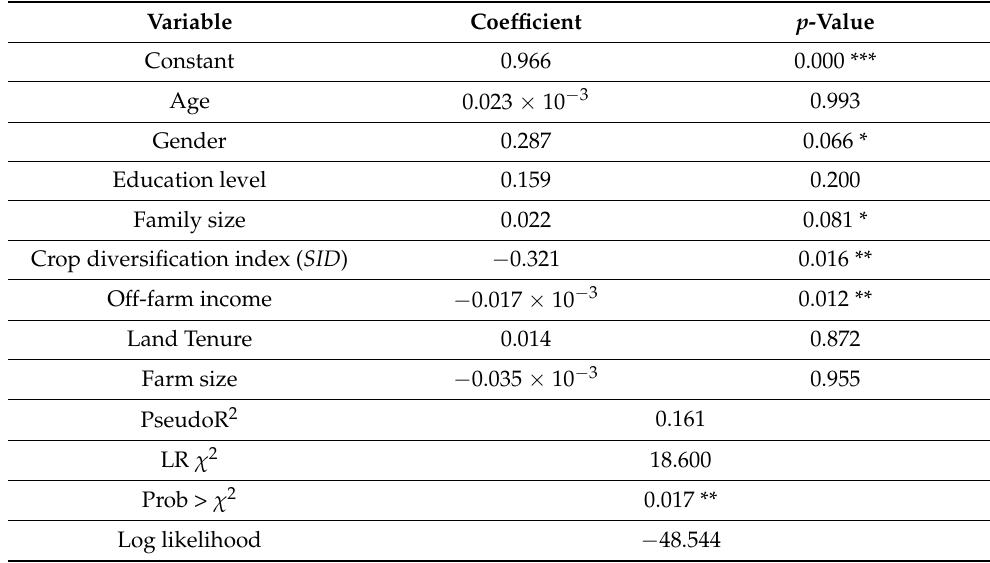
Figure 1. Kernel distributions of the efficiency level and the crop diversification index. Table 4. Technical efficiency effect